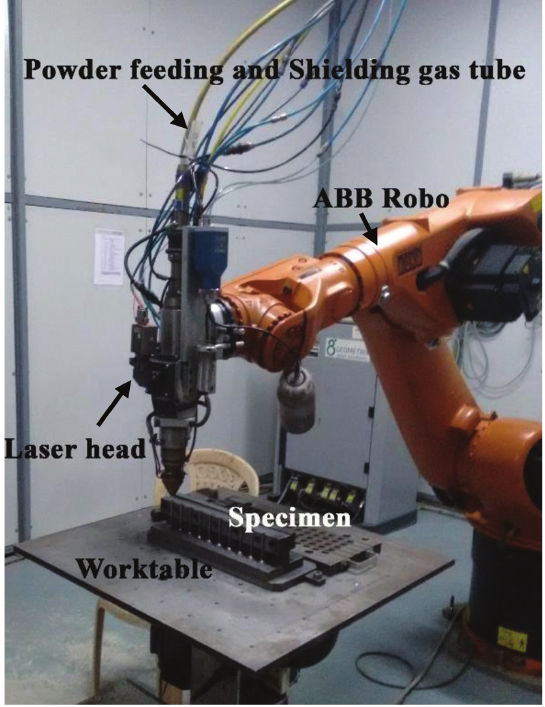
Table 3: Physical properties of hardfaced powder. Flow rate